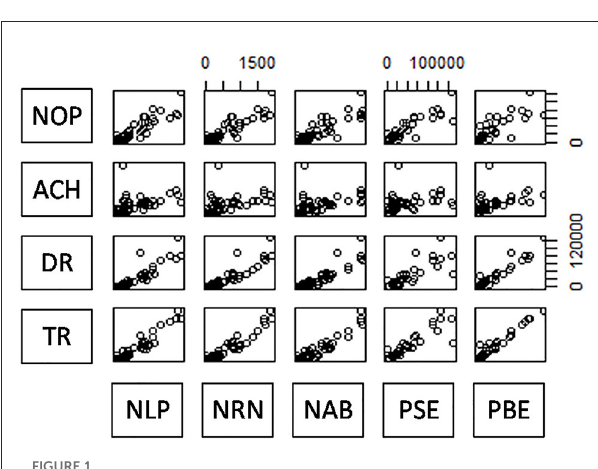
FIGURE1 Scatterplot matrix of input and output indicators. NOP-PAE represents the number of physicians, nurses, beds, personnel expenditure, and public management expenditure. OV-TI represents the number of outpatient visits, the average cost of hospitalization, drug revenue, and total income.